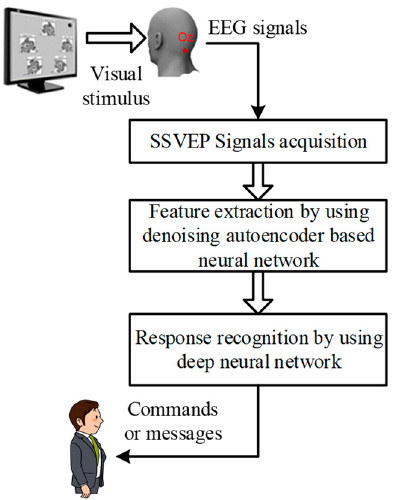
Figure 1. The flowchart of the proposed robust SSVEP-based BCI.